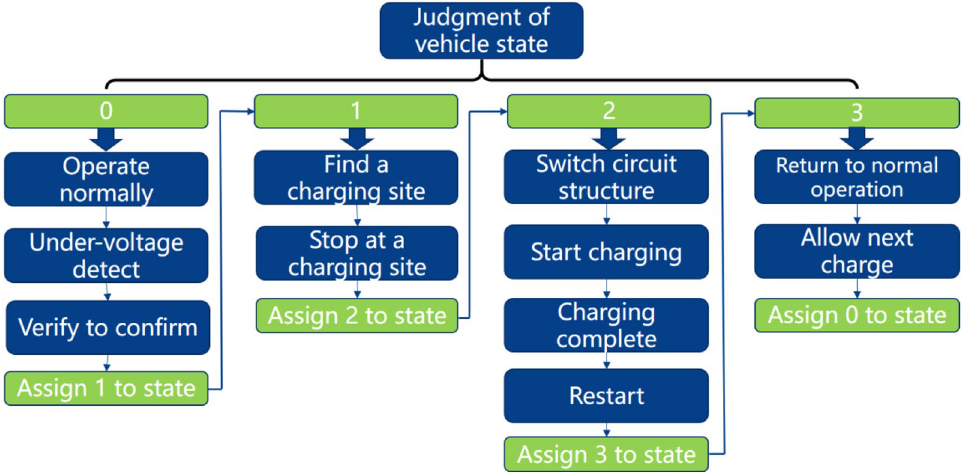
Figure 6 Flowchart of automatic charging